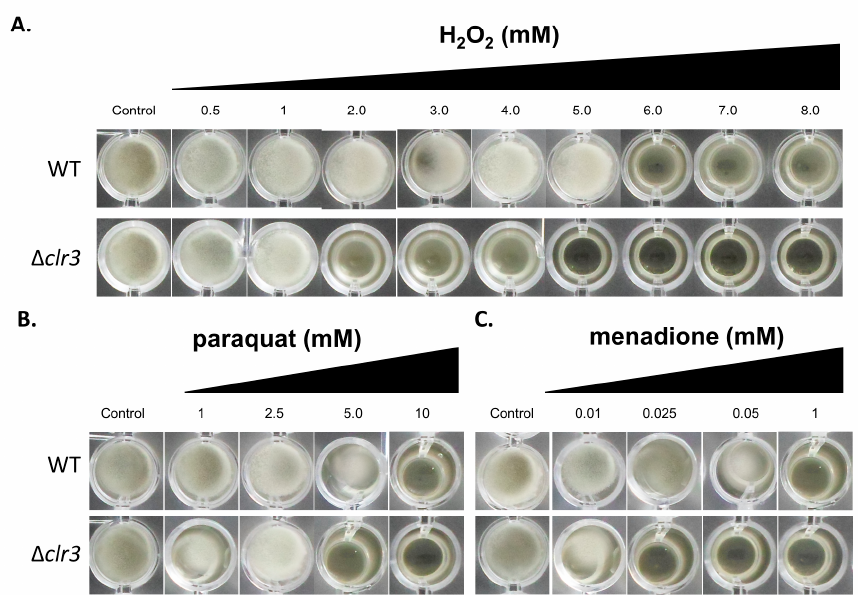
Figure 2. clr3 -null mutants exhibited sensibility to oxidative stress caused by H 2 O 2 , paraquat, and menadione. The 1 × 10 4 conidia of wild-type (WT) and mutant strains were inoculated in 200 µ L of PD broth (96-well plates) supplemented or not with varying concentrations of ( A ) H 2 O 2 , ( B ) paraquat, and ( C ) menadione. Plates were incubated at 30 ◦ C for 72 h and then photographed.